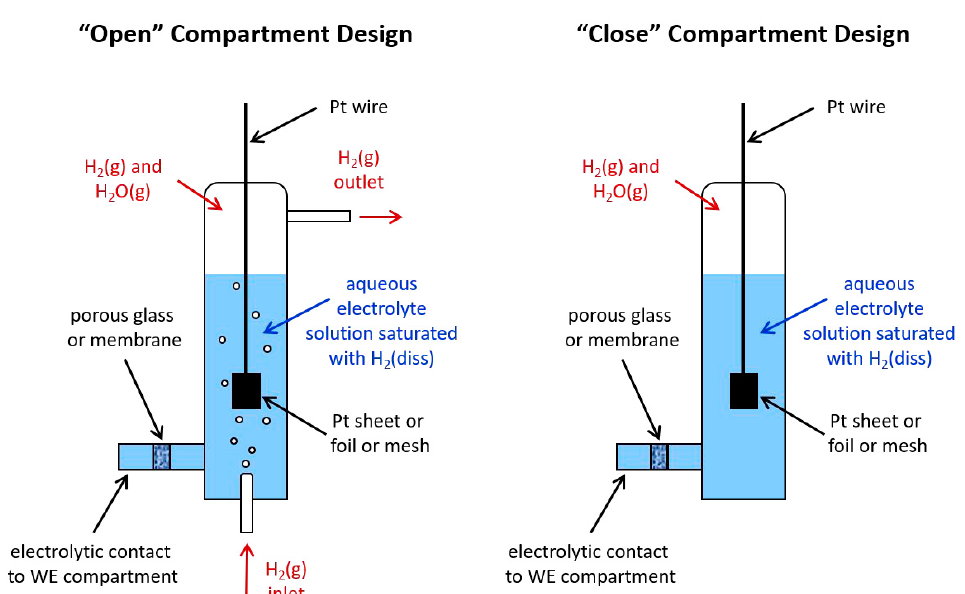
Figure 3. “Open” and “close” designs of the reference electrode compartment of the hydrogen ref- erence electrode, reprinted with permission from reference [56]. (Copyright, ACS,